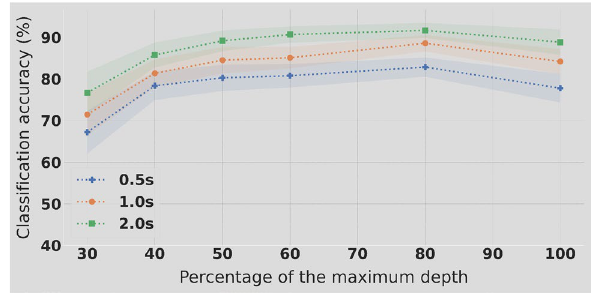
Figure 4. Experiment 2: classification accuracy in % using 4 classes (12, 14, 16 and 18 Hz) in function of different levels of amplitude stimulation depth and considering 3 epochs lengths.